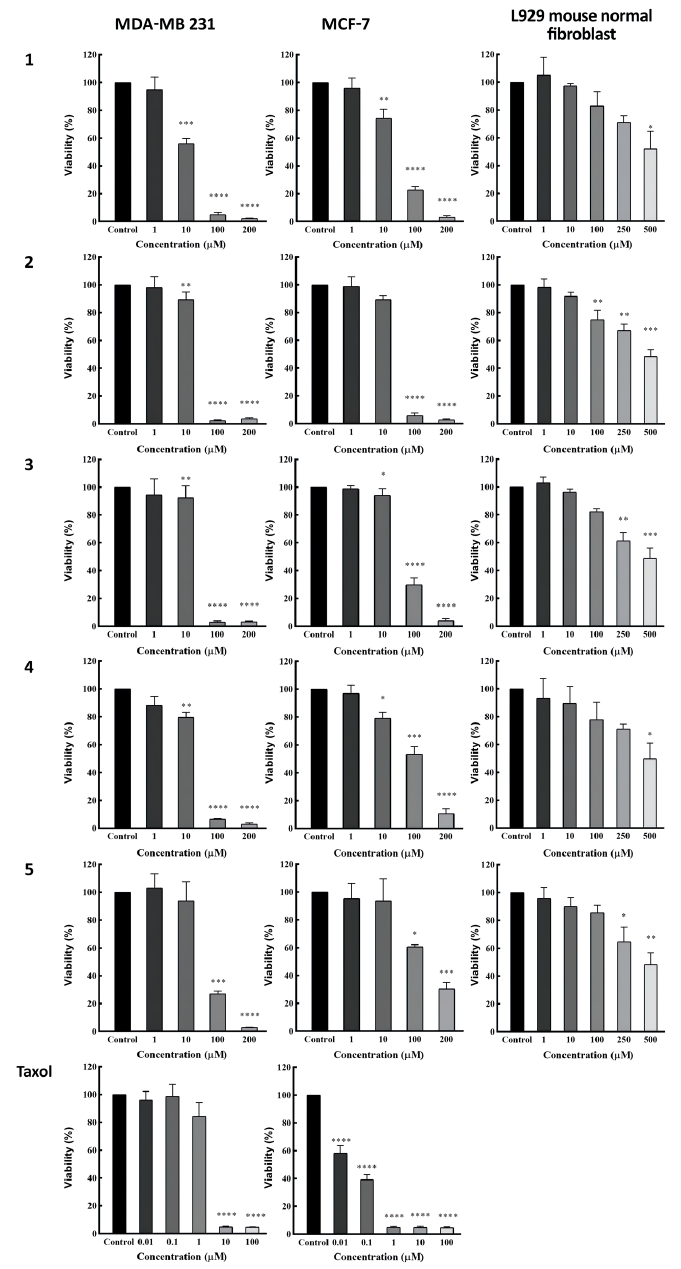
Figure 4. Cytotoxicity activity by using MTT viability assay against MCF-7, MDA-MB231, and L929 normal cell lines. These cells were treated with various concentrations of compounds 1–5 and Taxol as the positive control. Results are presented as the mean ± SD (n = 3). * p < 0.05, ** p < 0.01, *** p < 0.001, and **** p < 0.0001 versus control